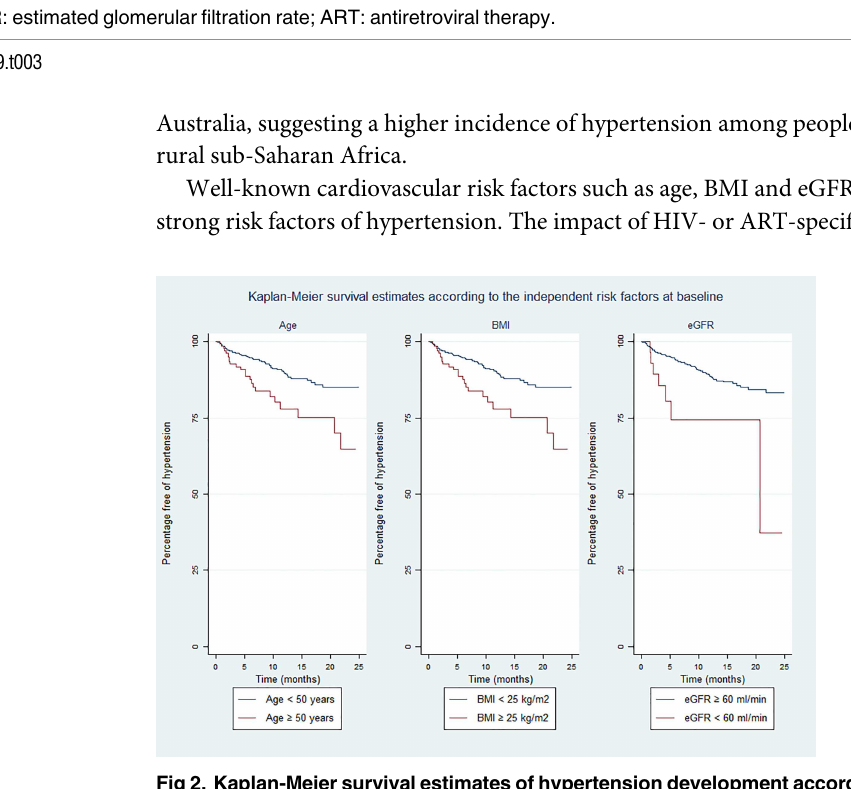
Fig 2. Kaplan-Meier survival estimatesof hypertension development according to the independent risk factors at baseline: age (left), body mass index (centre) and estimated glomerular filtration rate (right). BMI: body mass index; eGFR: estimated glomerularfiltration